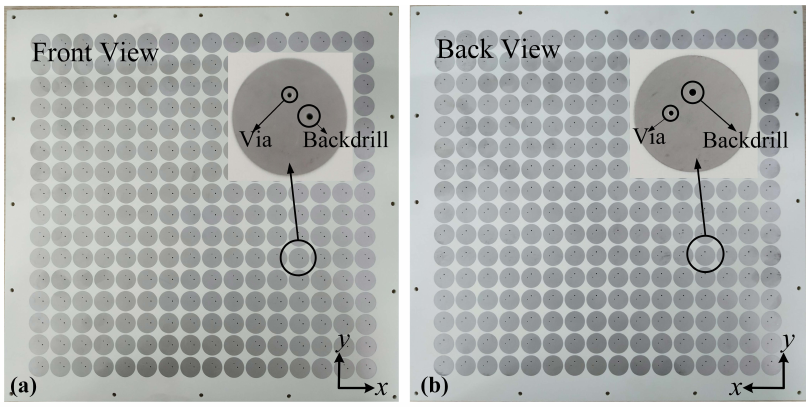
Figure 8. Photos of the fabricated metasurface: ( a ) Front view. ( b ) Back